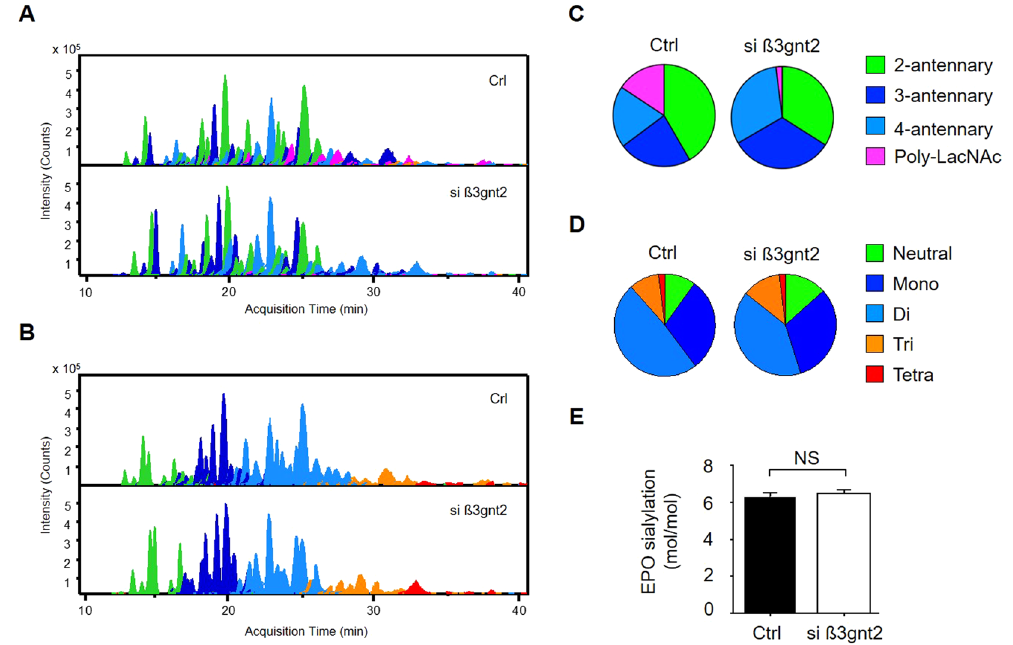
Figure 3. Comparison of N-glycan profiles and sialic acid contents. Distributions of N-glycan antennal branching ( A ) and sialylation ( B ) presented using Extracted Compound Chromatograms (ECCs) with the control above and the β 3gnt2-depleted cells below. The data in ( A ) and ( B ) are quantified in ( C ) and ( D ), respectively. ( E ) Sialic acid content was determined using the OPD-labeling method. The data shown are presented as means ± S.E.M. from three independent experiments each with duplicate samples. NS, not significant (Student’s